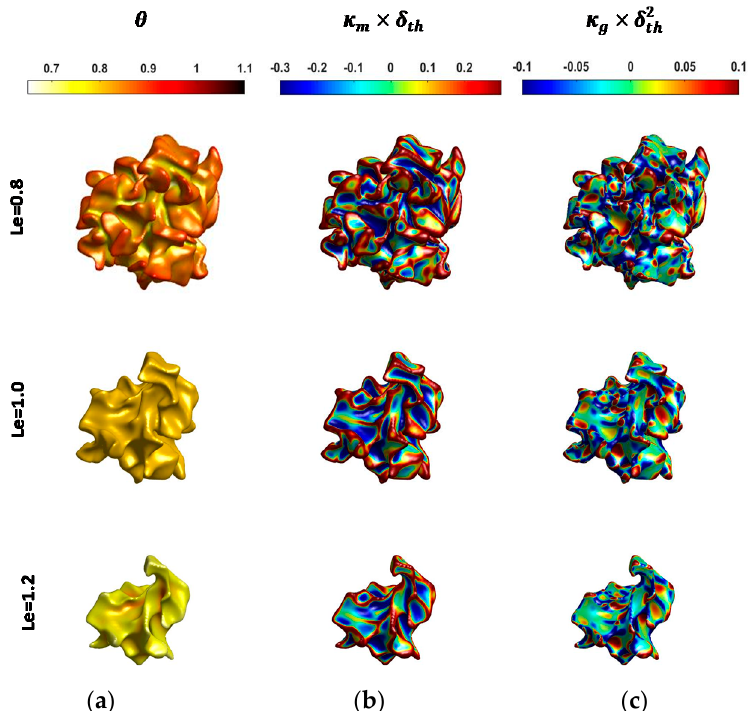
Figure 1. Instantaneous isosurfaces of reaction progress variable c = 0.8 colored by non-dimensional temperature θ ( a ), local values of normalised curvature κ m × δ th ( b ) and normalised Gauss curvature κ g × δ 2 ( c ) for cases with Le = 0.8, 1.0 and 1.2 (1st–3rd row).